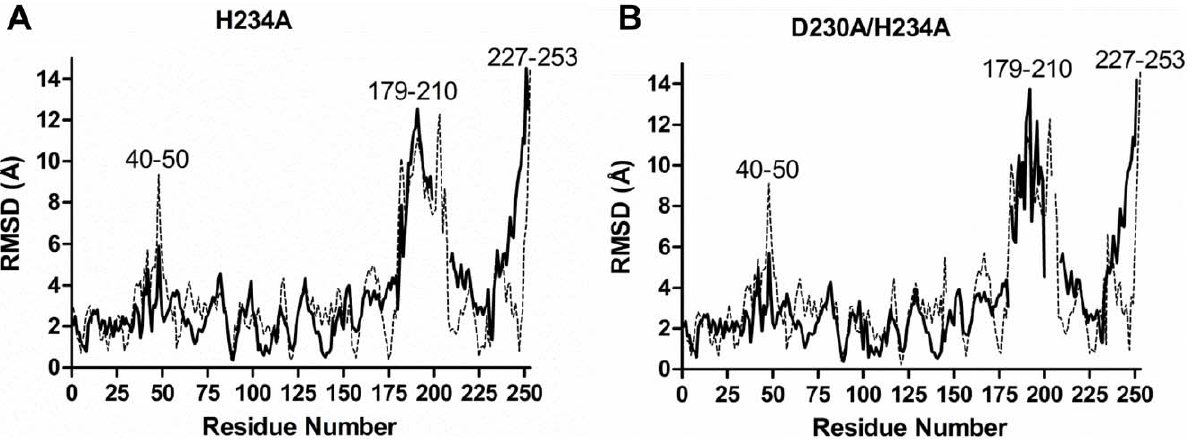
Figure 5. Deviations of equivalent C a atoms after structural superposition plotted against residue number. A) Comparison of wild type and H234A mutant. B) Comparison of wild type and D230A/H234A. Results of comparing A and B chains are shown in darker and lighter shades, respectively.